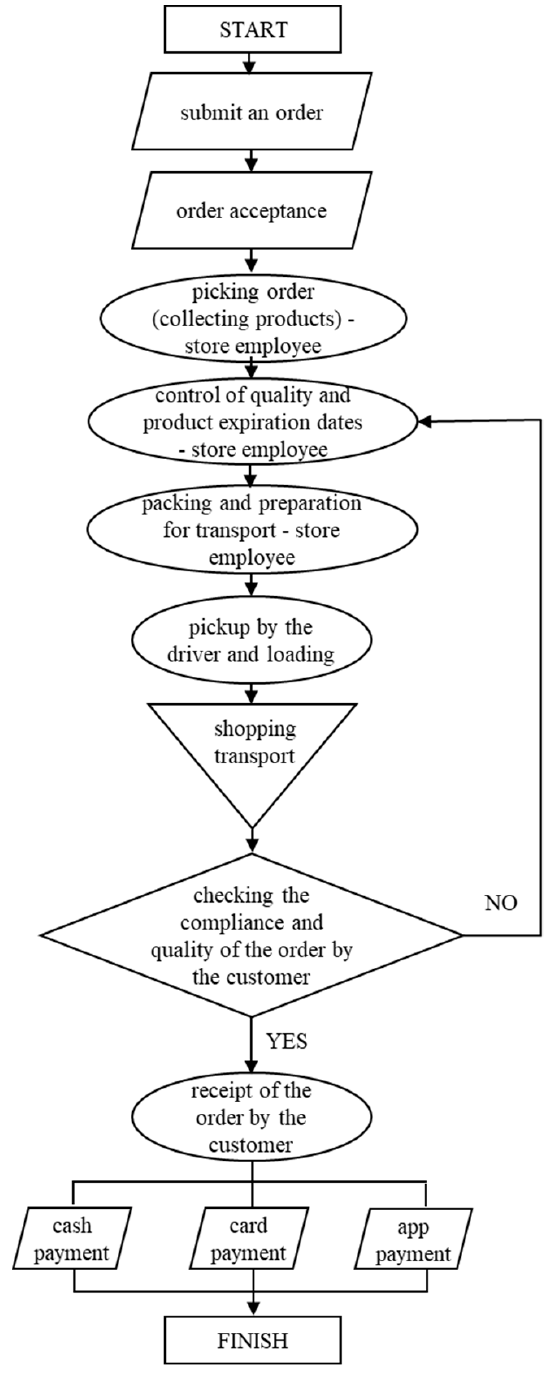
Figure 5. Shopping delivery process algorithm in terms of the DHI methodology.